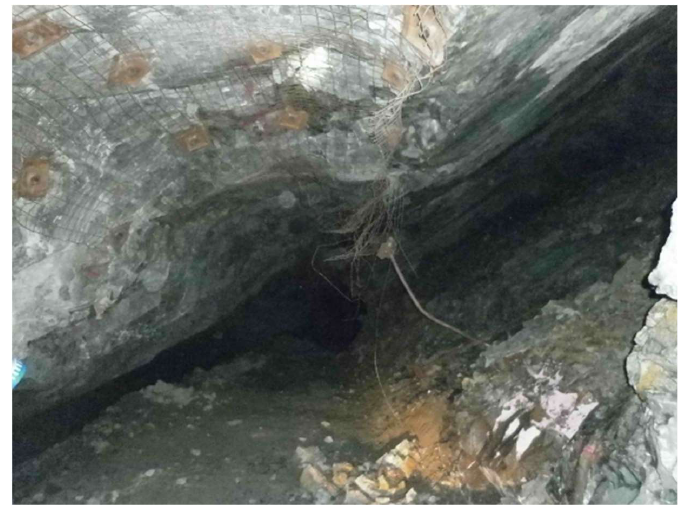
Figure 2. Development drive and low-angle stope floor after mucking by scraper. Remaining fine material in both the drive and stope floor contain liberated gold. Stope width approx. 2 m.